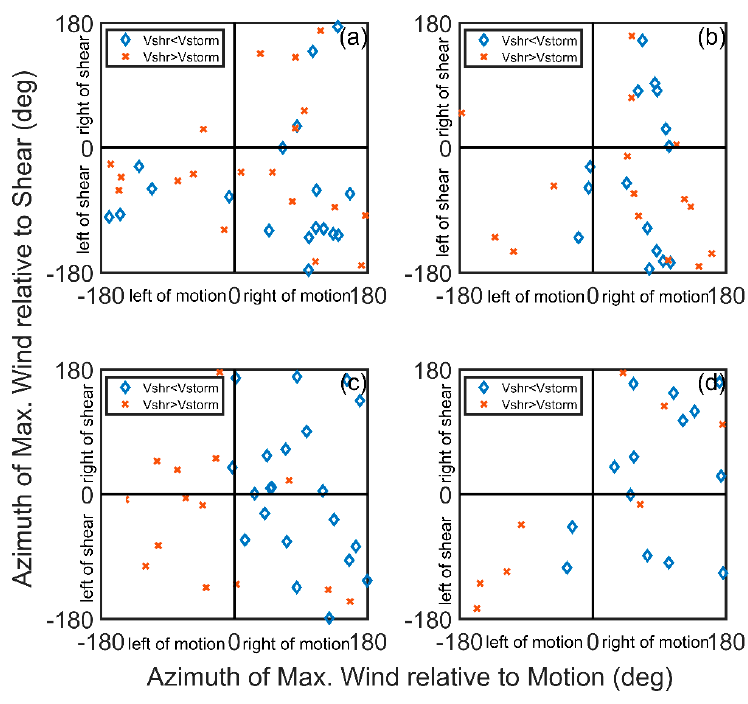
Figure 11. Azimuth angle of the wind maximum to the storm movement versus the azimuth angle of the wind maximum to vertical wind shear for ( a ) a tropical storm, ( b ) typhoon, ( c ) severe typhoon, and ( d ) super typhoon as shown in Figure 3. The blue diamond indicates that V storm is larger than V shear , and the red cross indicates that V storm is smaller than V shear